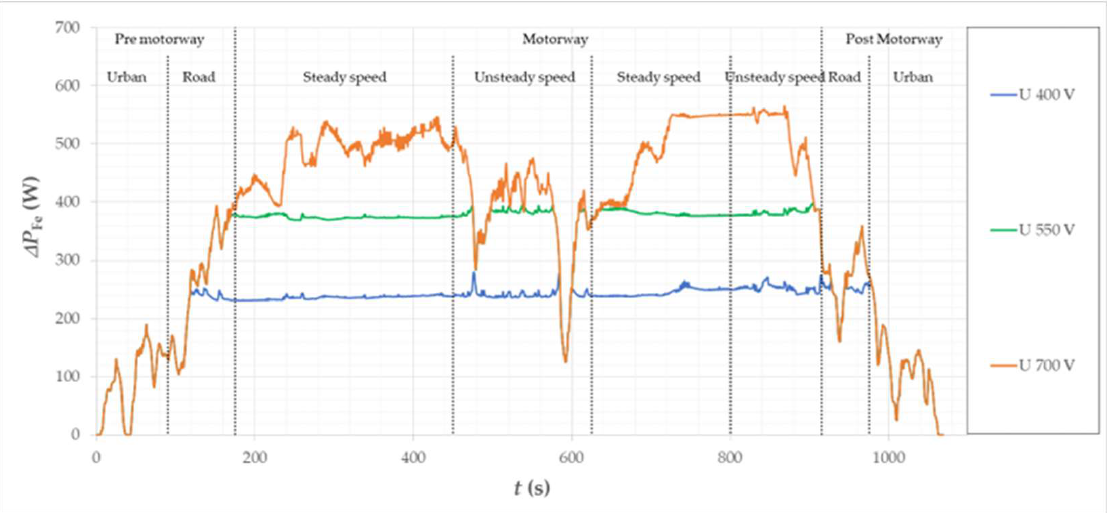
Figure 35. Calculated loss waveforms in the stator core of the motor for the considered vehicle in the Artemis Motorway150 cycle .